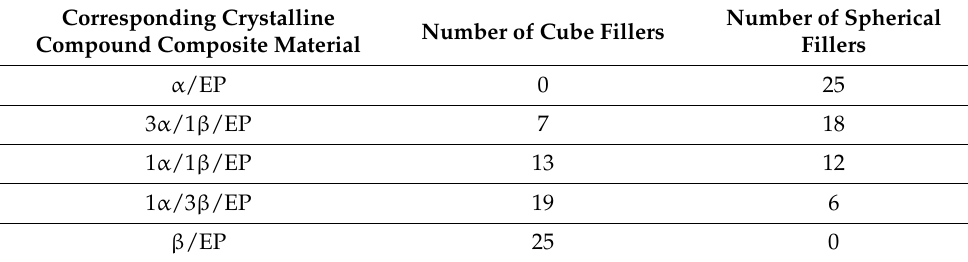
Table 4. The number of filler particles in the RVE geometric model.